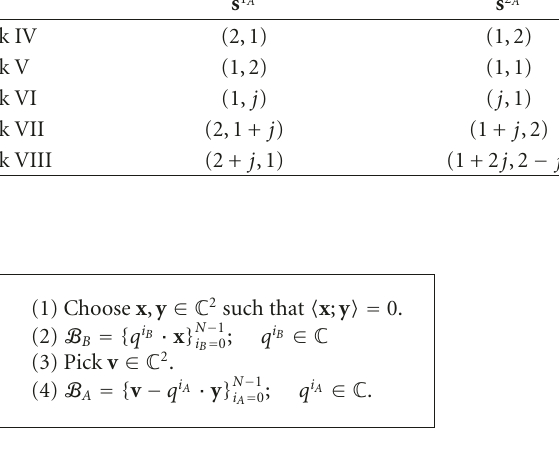
Algorithm 2: Higher-order codebook—example